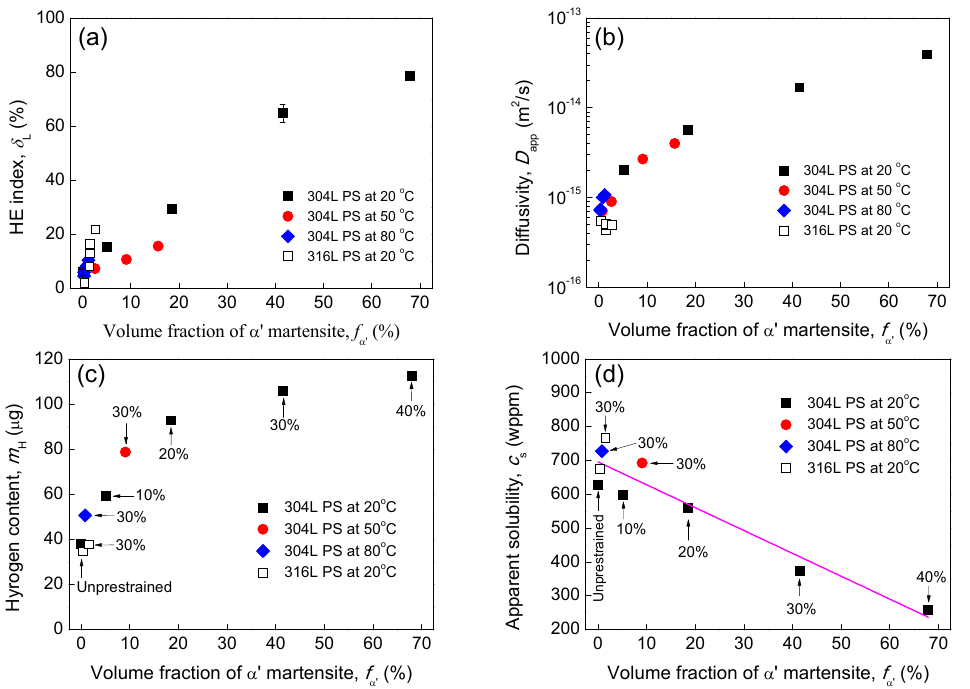
Figure 11. HE indexes ( a ), apparent hydrogen diffusivity ( b ), total hydrogen amount ( c ), and apparent solubility ( d ) of specimens un ‐ prestrained and prestrained (PS) as a function of α′ volume fraction.